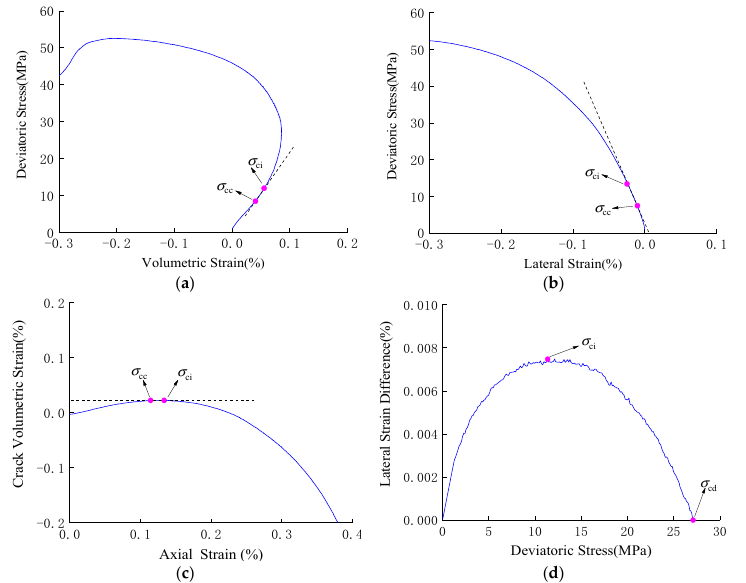
Figure 4. Different methods to determine the σ cc or σ ci values: ( a ) VS; ( b ) LS; ( c ) CVS; and ( d ) LSR.